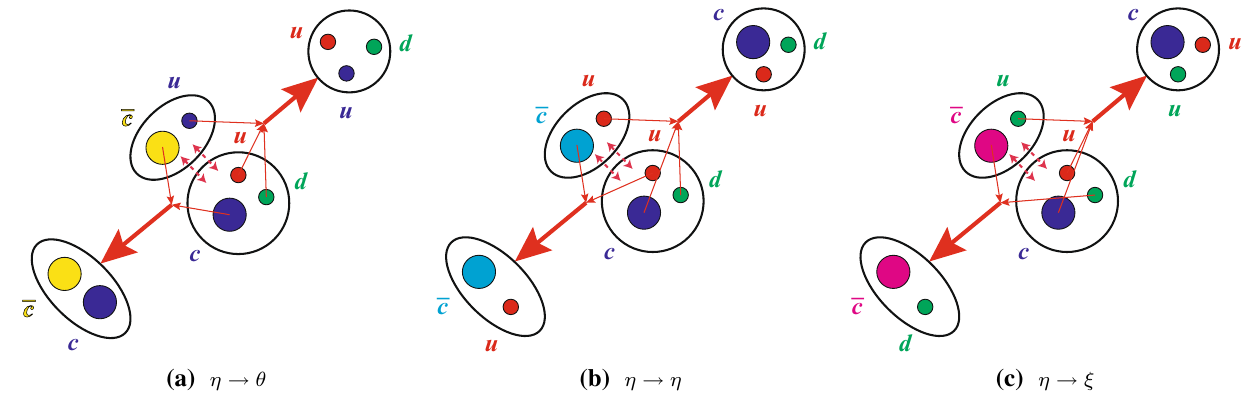
Fig. 2 Fall-apart decays of P c states as ¯ D ( ∗ ) 0 Σ + c molecular states, investigated through the η( x , y ) currents. There are three possibilities: a η → θ , b η → η , and c η → ξ . Their probabilities are the same (33%), if only considering the color degree of freedom